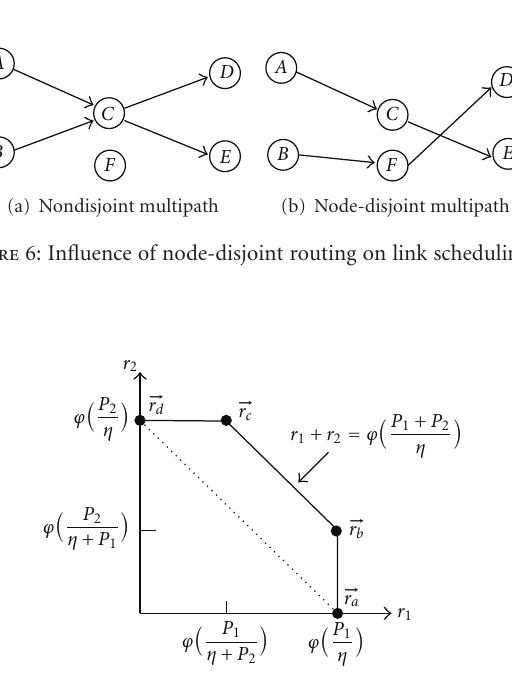
Figure 7: Capacity region of a multiaccess channel for a receiver node receiving data from two simultaneous transmitters.